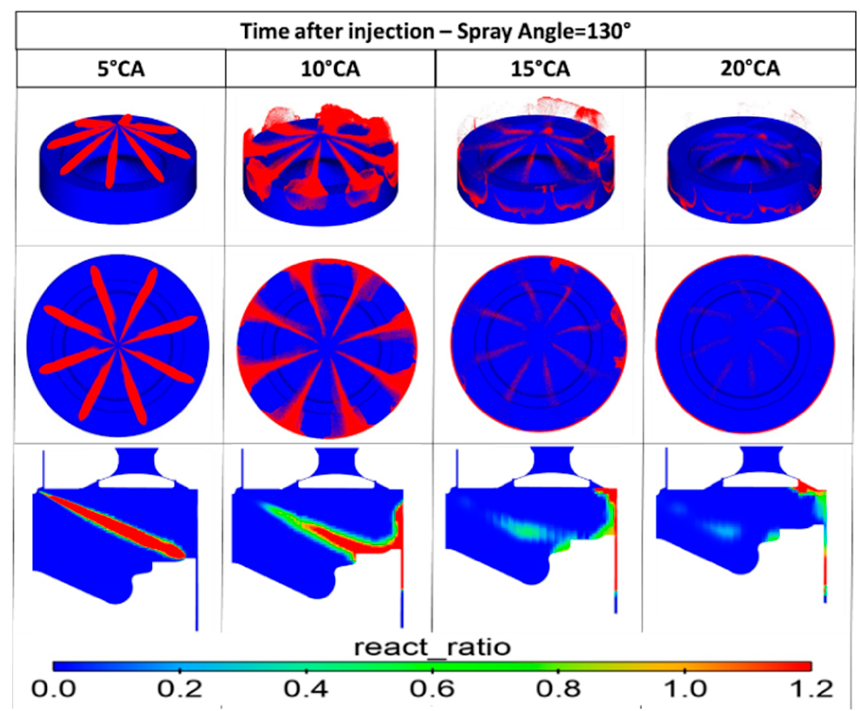
Figure 30. For an SIA of 130°, spray penetration in oblique side and top views and RER contour plot in a planar section through the cylinder axis and a spray axis.